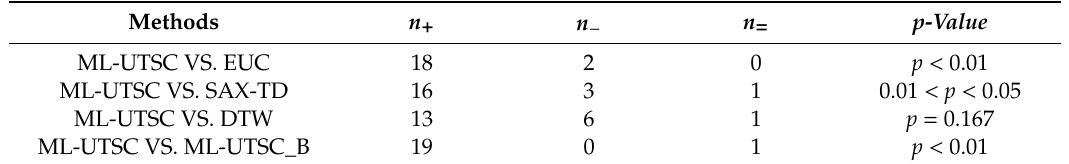
Table 3. Comparison of p -values by di ff erent methods.